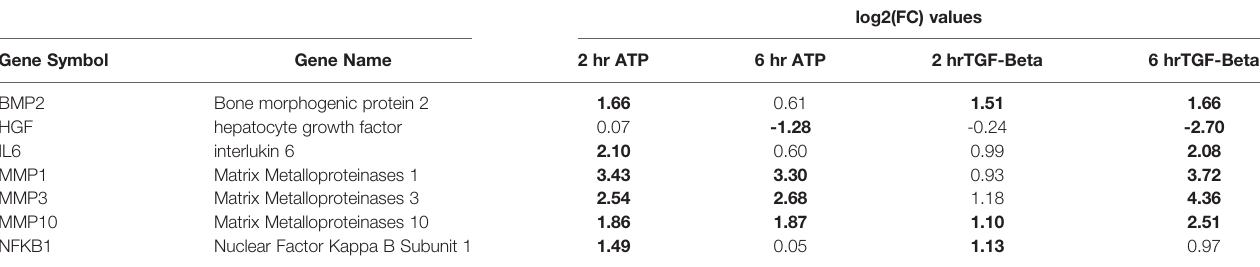
TABLE 2 | EMT genes signi fi cantly changed by both the ATP and TGF- b treatments (but may not be changed signi fi cantly at all time points).